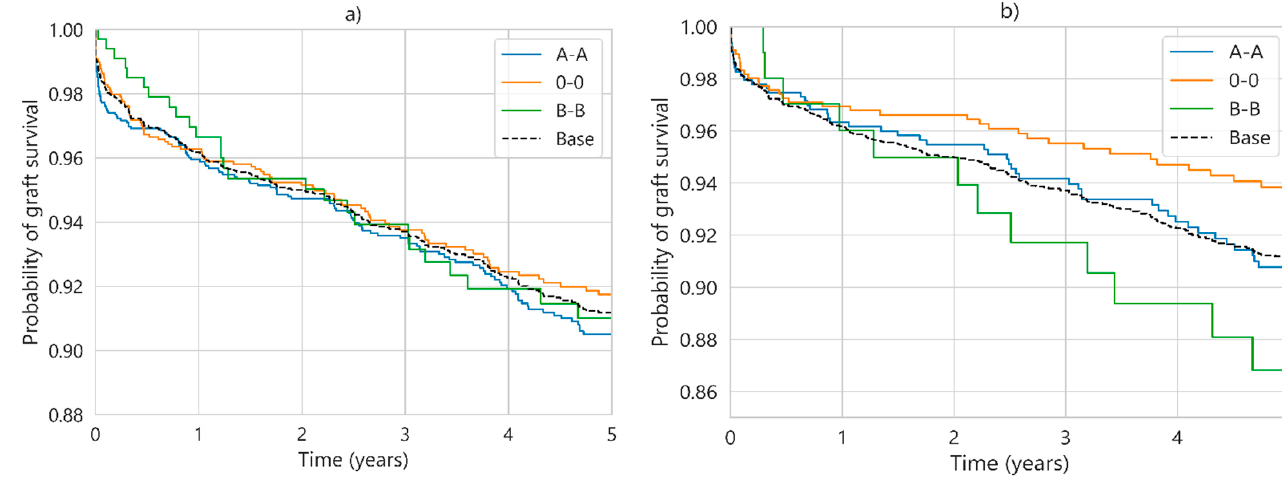
Figure 7. Five-year survival probability considering by blood group for SICATA, where ( a ) captures all cases ( p > 0.5), and ( b ) shows only cases where aHLA is three or lower ( p < 0.05). Table 4. Cox multivariate proportional hazards analysis of censored graft survival to failure for SICATA and UNOS at three years for all